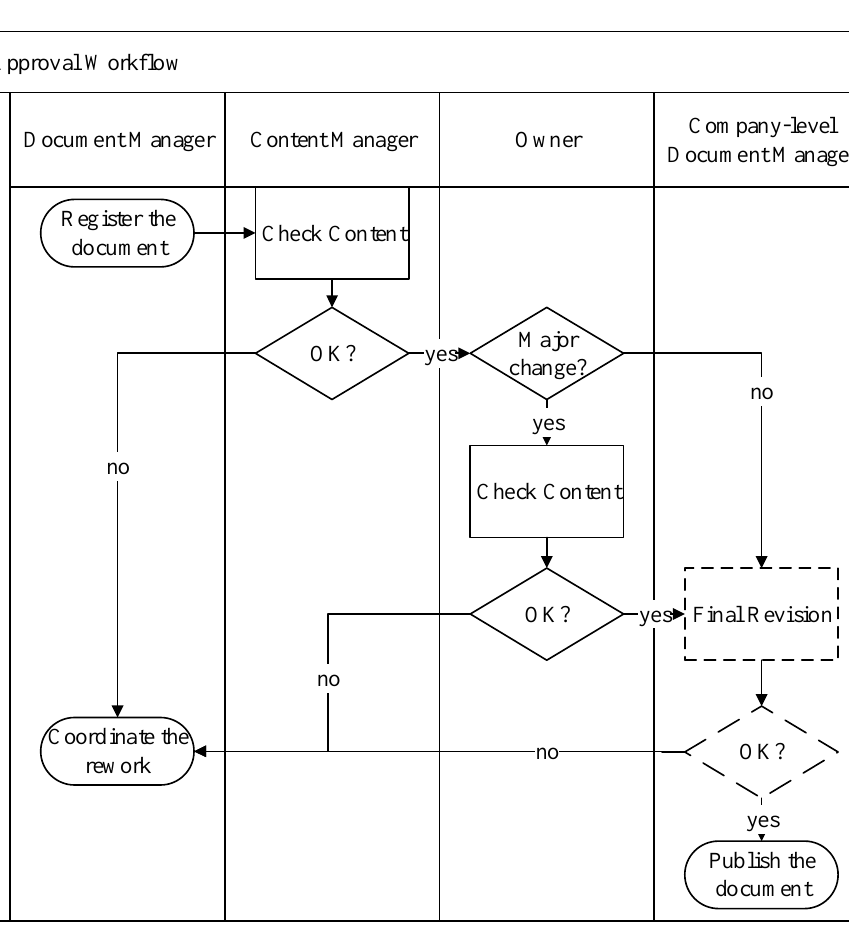
Figure 2 – Approval